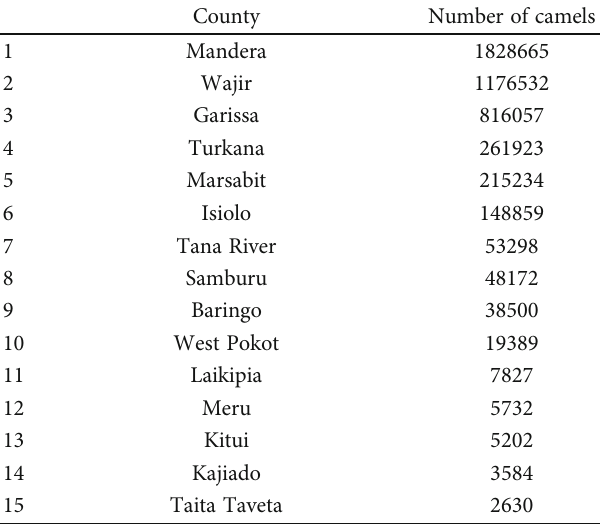
Table 2: Camel population in selected counties in Kenya.